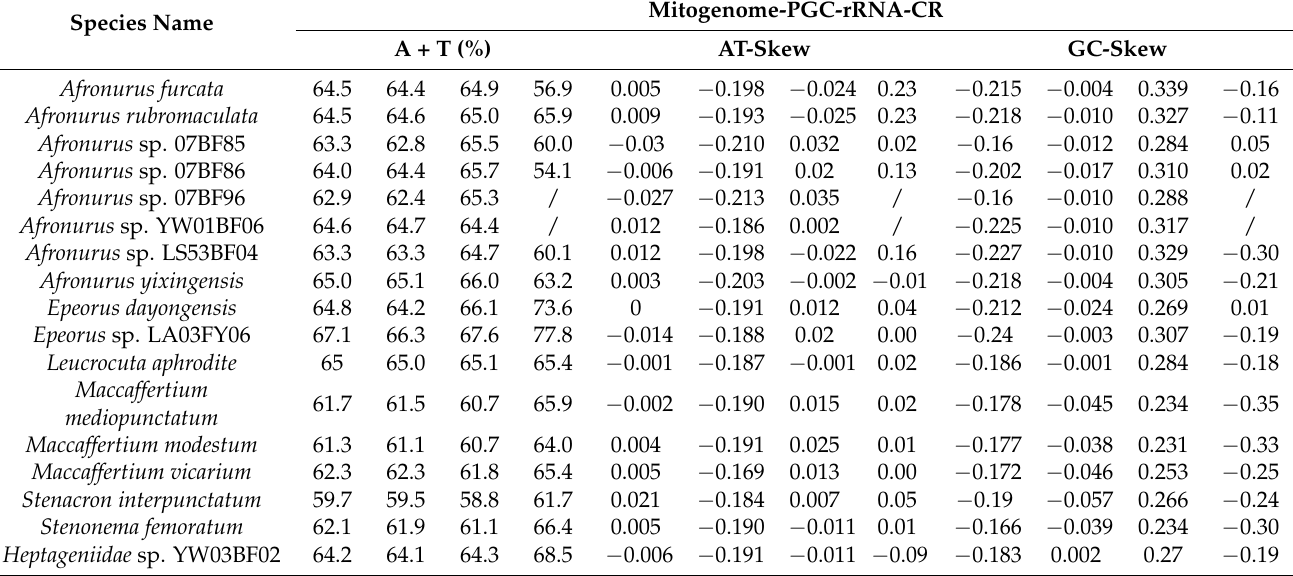
Figure 1. Circular visualization and organization of the complete mitogenome. External genes on the circle are encoded by the positive strand (5 (cid:48) → 3 (cid:48) ) and internal genes are encoded by the negative strand (3 (cid:48) → 5 (cid:48) ). ( A ) Mitogenomes in the subfamily Ecdyonurinae ( Afronurus and Leucrocuta ) and Rhithrogeninae ( Epeorus ); ( B ) mitogenomes in the subfamily Heptageniinae ( Maccaffertium , Stenacron , and Stenonema ). Table 3. Base composition of 17 mayfly mitochondrial genomes, with a greater separation of each of the three Mitogenome-PGC-rRNA- CR groups and separate underlining to mark the three different